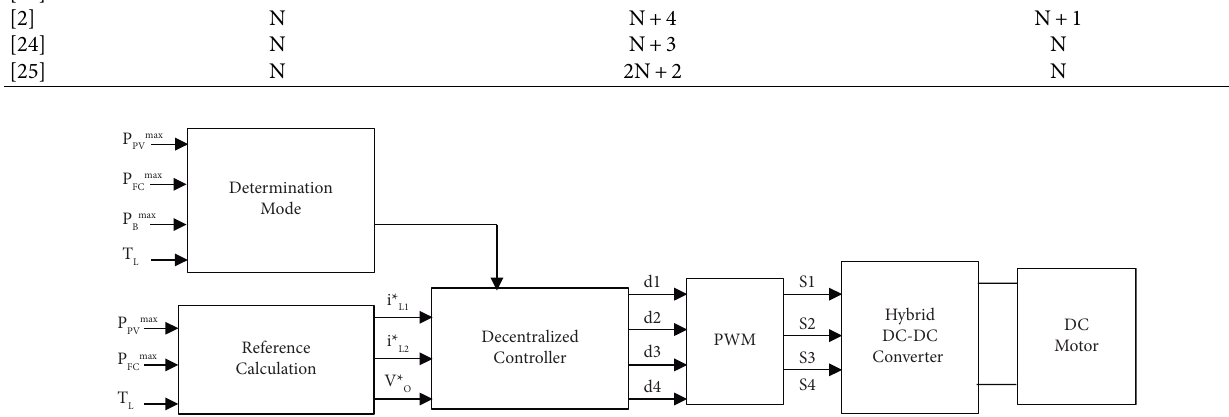
Figure 13: General scheme of the proposed Table 4: Converter simulation parameter.